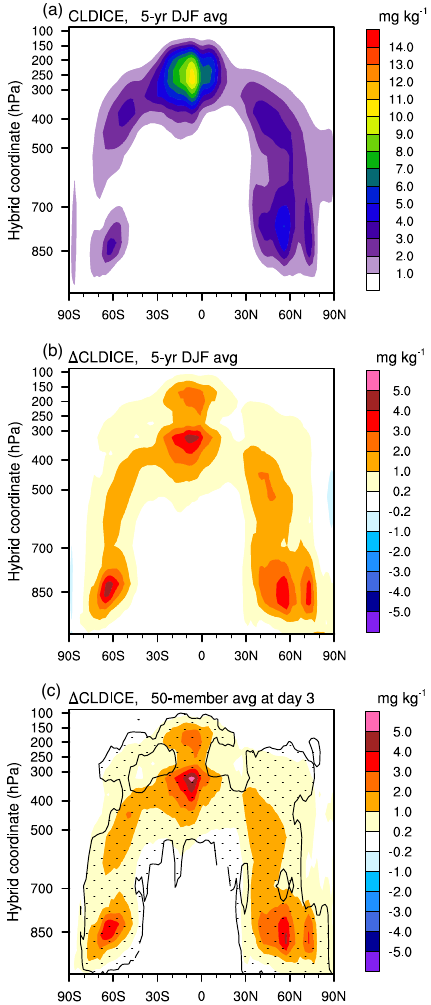
Fig. 3. (a) Zonally averaged, 5yr DJF mean mass concentration of stratiform cloud ice (unit: mgkg − 1 ) simulated by CAM5 using tion of stratiform cloud ice (unit: mg kg − 1 ) simulated by CAM5 a 30min time step. (b) 5yr DJF mean cloud ice mass concentration using a 30min time step. (b) 5-year DJF mean cloud ice mass differences between simulations using 4min and 30min time steps concentration differences between simulations using 4 and 30min (unit: mgkg − 1 ). (c) As in panel (b) but showing the 50-member time steps (unit: mg kg − 1 ). (c) As in panel (b) but showing the 50- ensemble mean at day 3. Stippling in panel (c) indicates locations member ensemble mean at day 3. Stippling in panel (c) indicates where the differences are statistically significant at 95% confidence locations where the differences are statistically significant at 95% level. Further details are explained in Sect. 3.2. confidence level. Further details are explained in Sect.